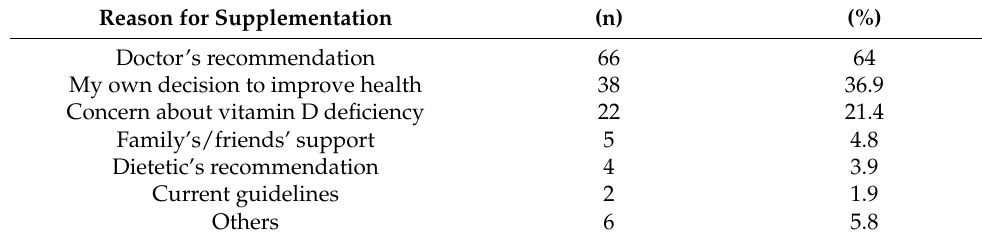
Table 5. MS patients’ reasons for vitamin D